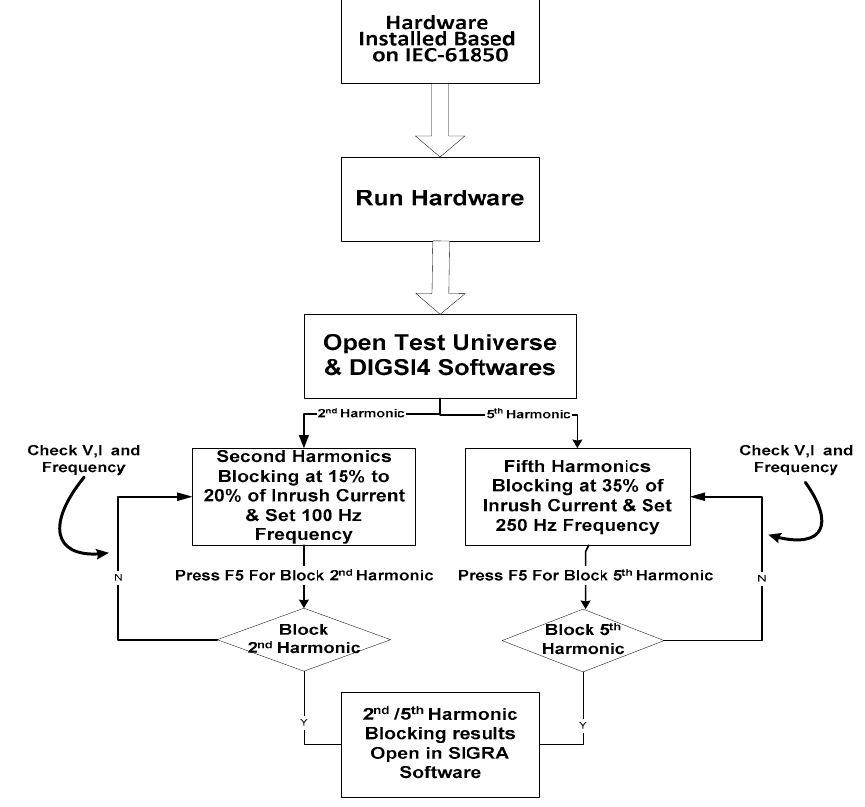
Figure 6. Flowchart depicting the Harmonic Blocking.